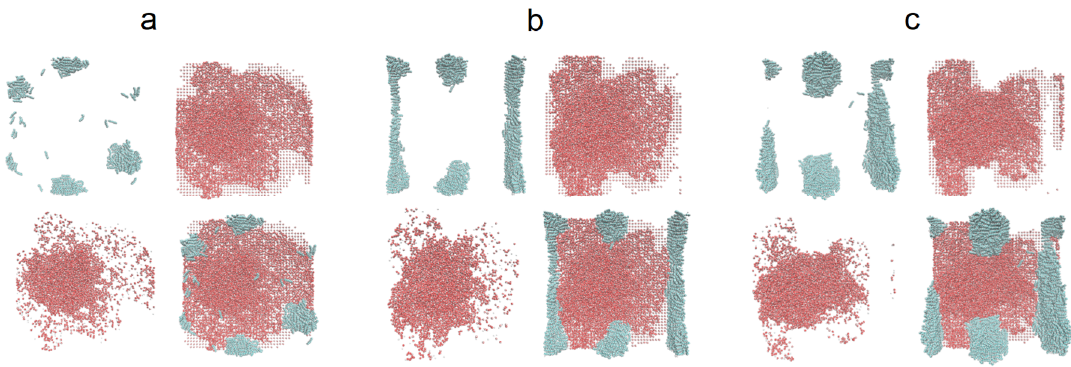
Figure 13. Simulation snapshots of water droplet on n-decane-covered silicon dioxide at surface density 0.59 ( a ), 1.47 ( b ), and 2.78 ( c ) molec / nm 2 . The top left-hand corner panel shows the snapshot of only the alkane molecules. The top right-hand corner panel shows only the water molecules. The bottom left-hand corner panel shows the water molecules but only those with z-coordinate greater than 2.55 nm. The bottom right-hand corner panel shows the snapshot of water nanodroplet with alkane molecules. The silicon dioxide surface is not shown for better clarity.